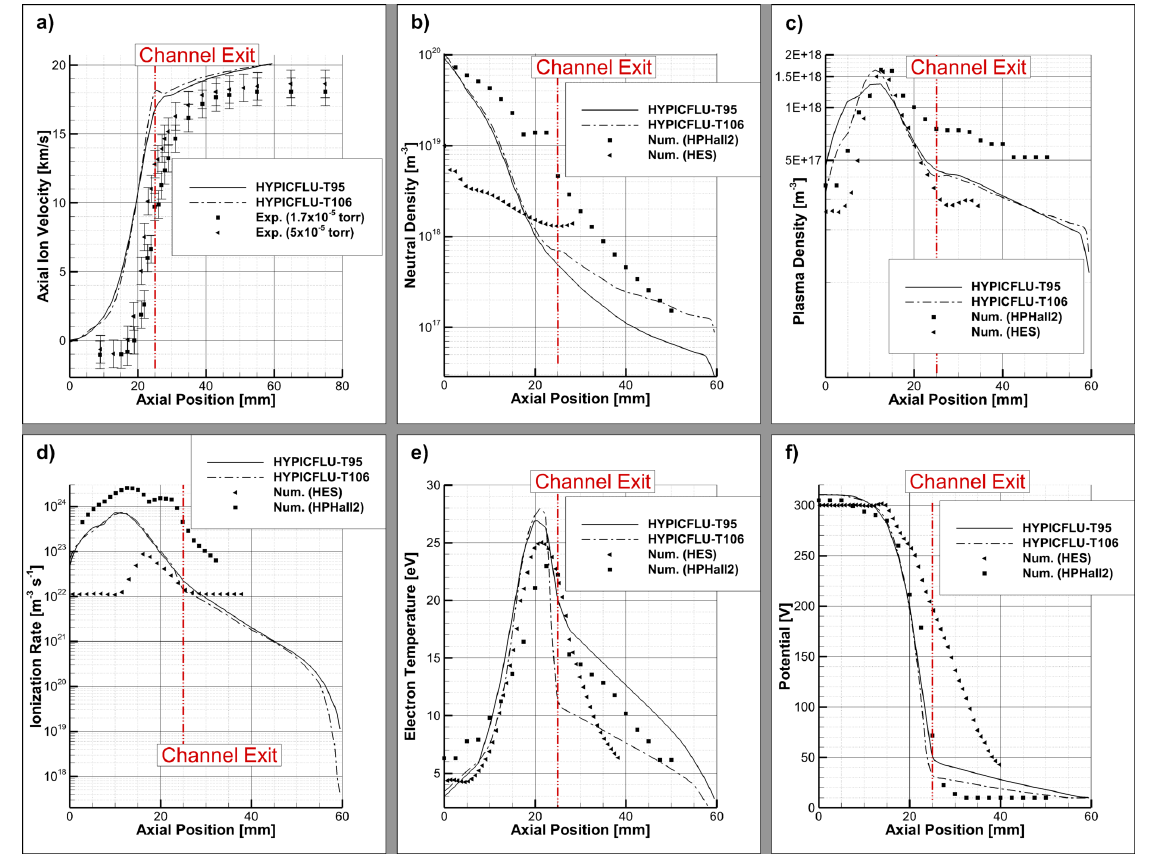
Figure 15. SPT-100 simulation: ( a ) axial ion velocity, ( b , c ) neutral and plasma densities, ( d ) ionization rate, ( e ) electron temperature and ( f ) plasma potential as a function of axial position (along a line going through the middle of the channel). HYPICFLU-Test 95 and HYPICFLU-Test106 curves have been extracted from Figures 13 and 14; experimental (Exp.) data have been taken from MacDonald-Tenenbaum et al. [36] and refer to two background pressure levels within the test chamber; numerical (Num.) results have been taken from Hofer et al. (using HPHall2 code) and Kawashima et al. (using HES-based code), respectively.